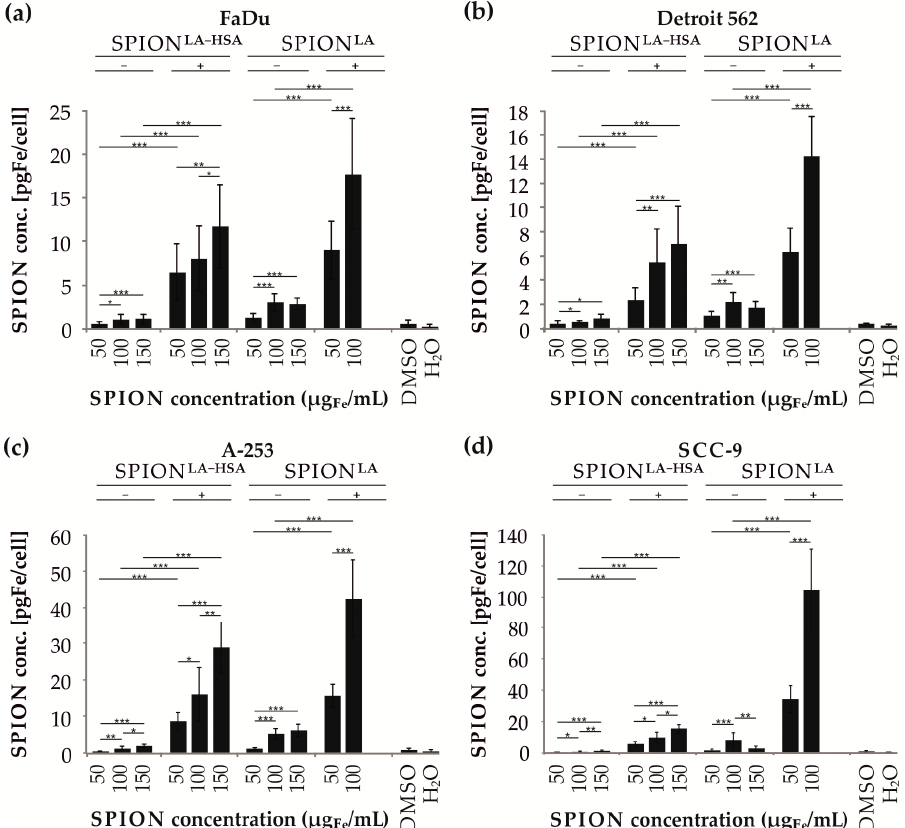
Figure 5. Quantification of the cellular nanoparticle load via MP-AES. The cell lines FaDu ( a ), Detroit 562 ( b ), A-253 ( c ) and SCC-9 ( d ) were spiked with 50, 100 and 150 µg Fe /mL SPION LA-HSA or SPION LA and further cultured either without ( − ) or on magnetic plates (+). Due to increased toxicity and low cell numbers, data sets obtained with 150 µg/mL SPIONLA in presence of magnets were removed for reliability reasons. Control samples contained the corresponding amount of H 2 O or DMSO at a final concentration of 2%. Data are expressed as mean standard deviation (n = 3 with technical triplicates). Statistical significances are indicated with *, ** and ***. The respective confi- dential intervals are p ≤ 0.05, p ≤ 0.001, and p ≤ 0.0001 and were calculated via Student’s t -test. Ab-